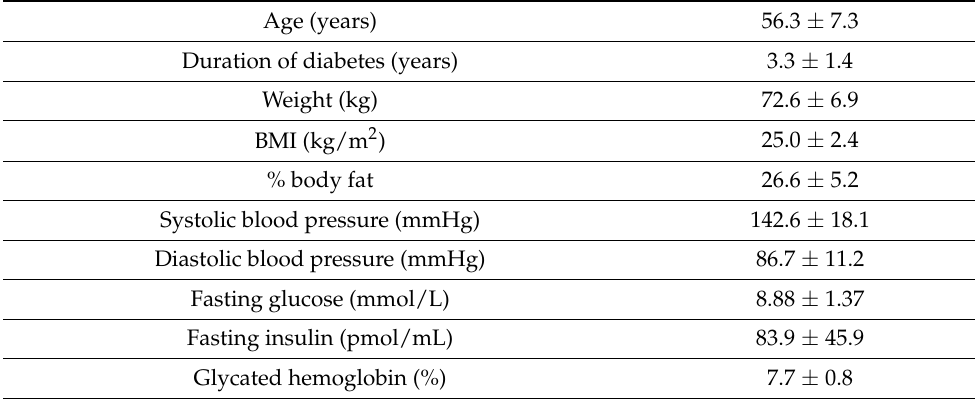
Table 1. Clinical characteristics of study participants at baseline ( n = 12).